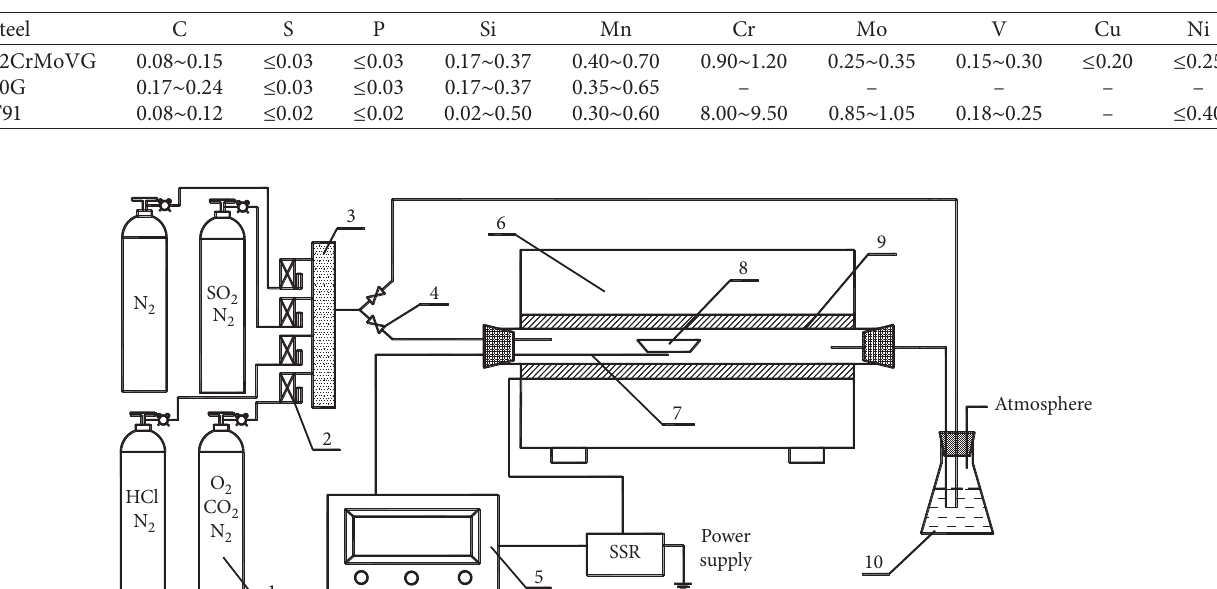
Figure 1: The schematic diagram of the experimental system. 1, gas cylinder; 2, gas flowmeter; 3, mixing equipment; 4, gas valve; 5, PID temperature controller; 6, tube furnace; 7, thermocouple; 8, porcelain boat; 9, corundum tube; 10, absorber bottle.